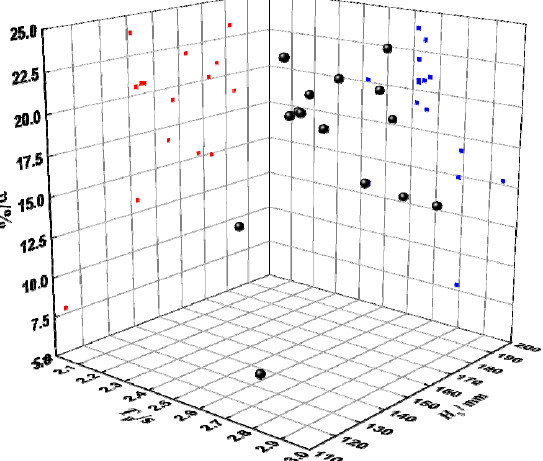
Figure 7. The wave-wire conversion characteristics of test model in irregular wave.